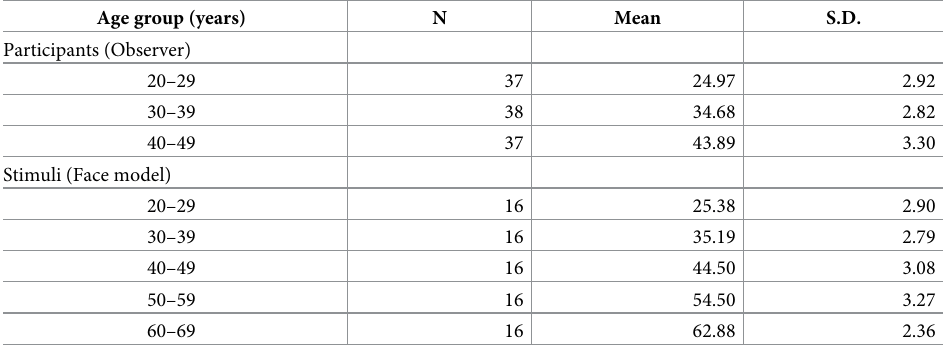
Table 1. Participant